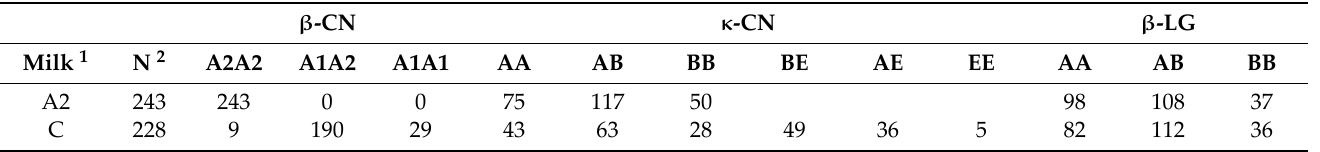
Table 2. Genetic information of tank milks used in this